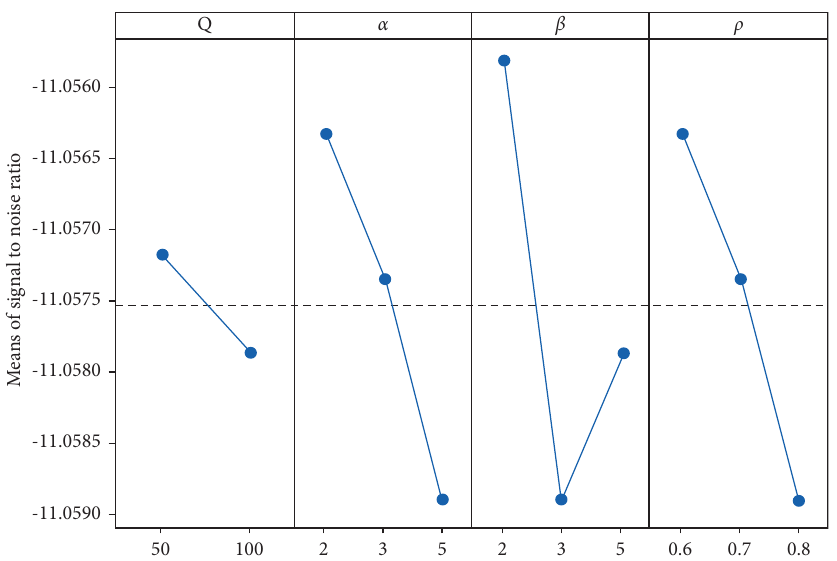
Figure 7: Signal-to-noise ratio main effect diagram.